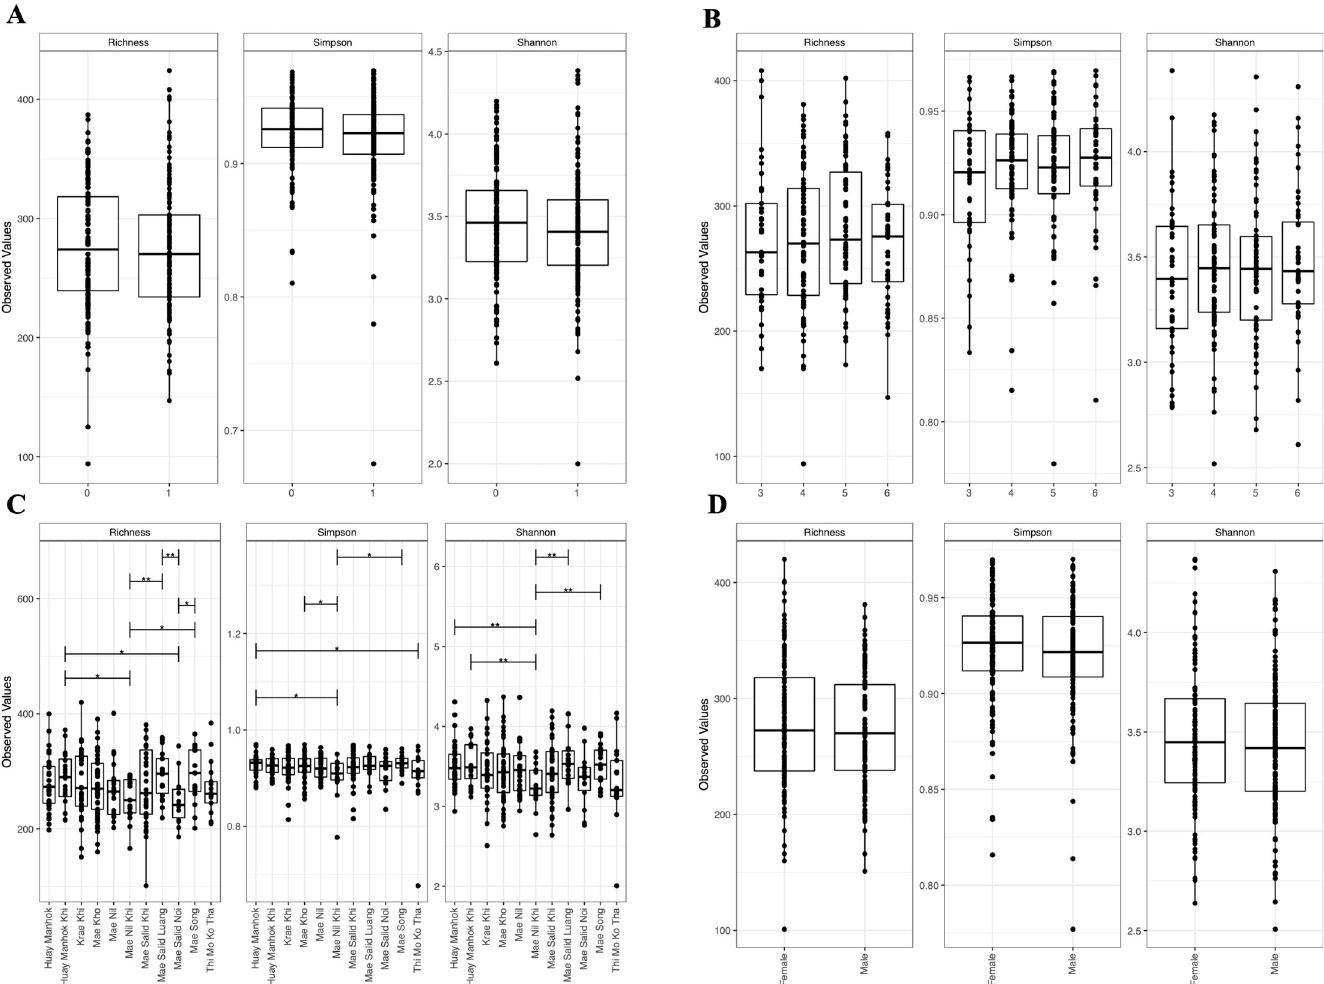
Fig 3. Alpha-diversity measures with analysis of variance (ANOVA) statistics of the complete cohort of faecal samples preserved in DESS ( n = 273). Statistical analysis was performed using a p-value cut-off of 0.05 ( � 0.05 �� 0.005 ��� 0.0005) for soil-transmitted helminth (STH) infection status as estimated by multiplexed- tandem qPCR (MT-PCR) (0 uninfected, 1 infected) (A), age (3 to 6 years) (B), school (C) and sex (female, male) (D).